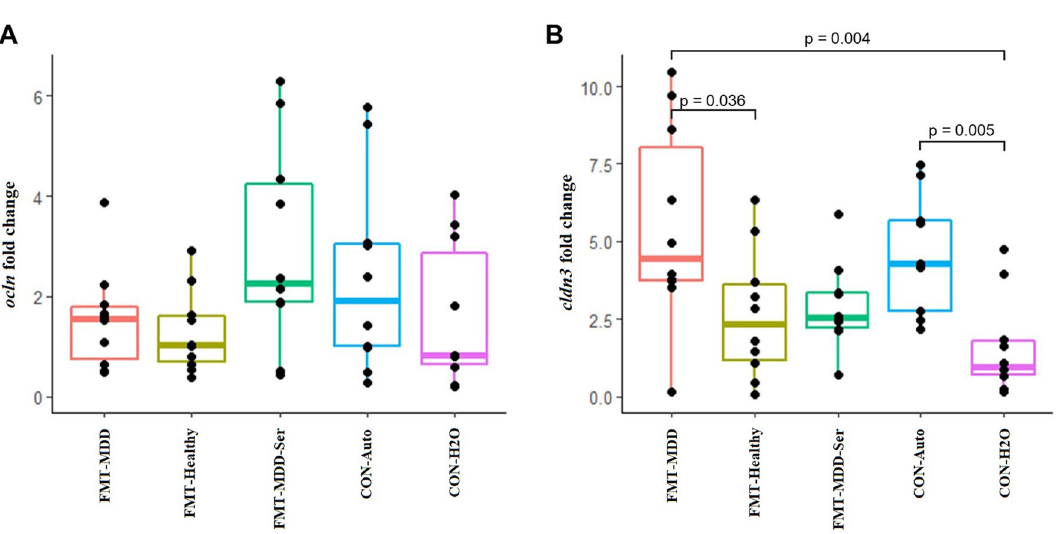
Figure 4. Relative mRNA expression of tight junction protein-encoding genes in the caecum of FRL rats. ( A ) Relative gene expression of ocln in rats. ( B ) Relative gene expression of cldn3 in rats. Gene expression was normalized against gene expression of Gapdh using the ΔΔCt method. FMT-MDD: Faecal microbiota transplantation from patients with MDD into rats. FMT-Healthy: Faecal microbiota transplantation from healthy individuals into rats. FMT-MDD-Ser: Faecal microbiota transplantation from patients with MDD into rats combined with treatment with sertraline. CON-Auto: Rats receiving auto-transplantations. CON-H2O: Rats receiving demineralised